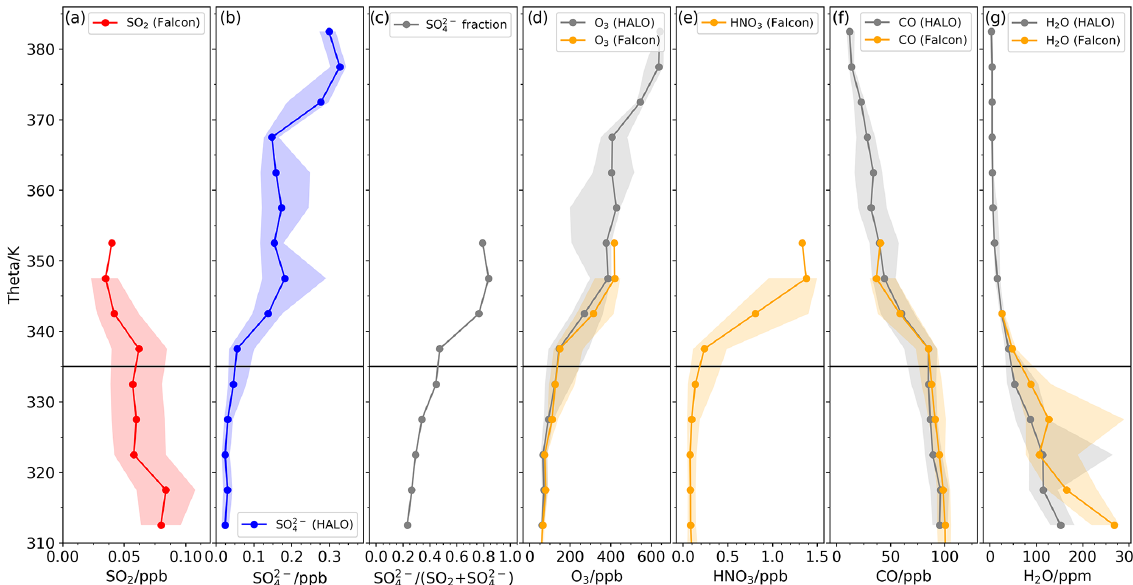
Figure 3. Median profiles with 25th and 75th percentiles as shaded areas are shown for trace gases with the potential temperature as vertical axes. The data are calculated for 5K potential temperature bins. (a) SO 2 , (b) SO 2 − (f) CO, and (g) H 2 O for measurements performed on HALO and Falcon . Additionally, the black line at 335K roughly indicates the dynamical tropopause (as 2PVU) based on ECMWF/ERA5 analysis along the Falcon flight tracks.